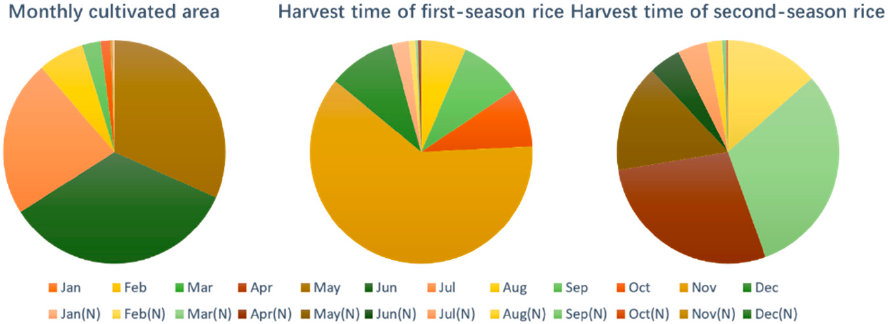
Figure 1. The percentage of monthly cultivated areas and monthly harvest productivities, where (N) refers to next year.